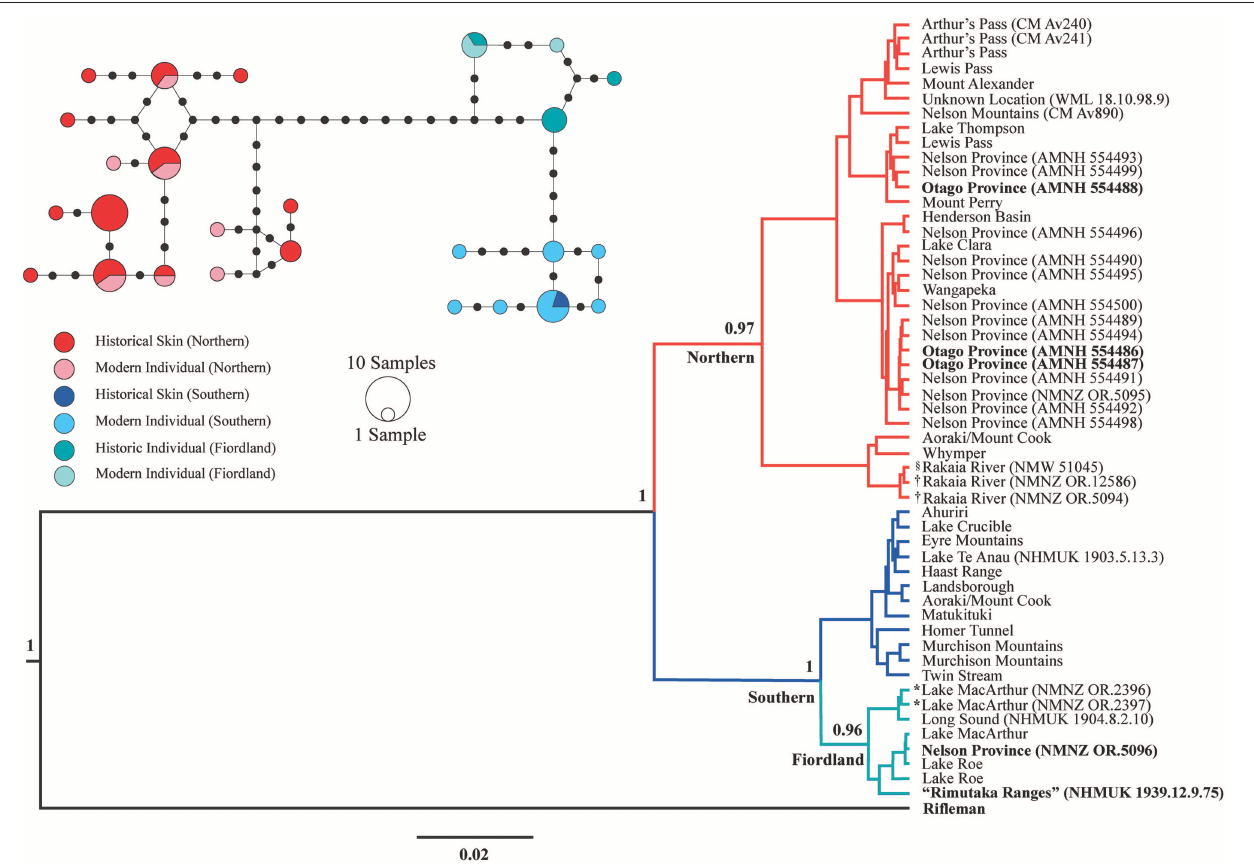
FIGURE 3 | Bayesian phylogeny and median-joining haplotype network of NZ rock wren ( Xenicus gilviventris ) mitochondrial control region sequences (284 bp). Major clades mentioned within the text are identified and posterior probabilities are displayed next to main nodes. Bold labels denote museum specimens for which the recorded collection locality and genetic sequence do not match. * X. gilviventris rineyi type series specimen, † X. haasti syntype, § X. gilviventris syntype. The scale bar depicts the distance corresponding to 0.02 nucleotide substitutions per site. Within the haplotype network, mutational steps are illustrated via small black circles, and haplotypes are colored according to genetic lineage and specimen type (contemporary individual or museum